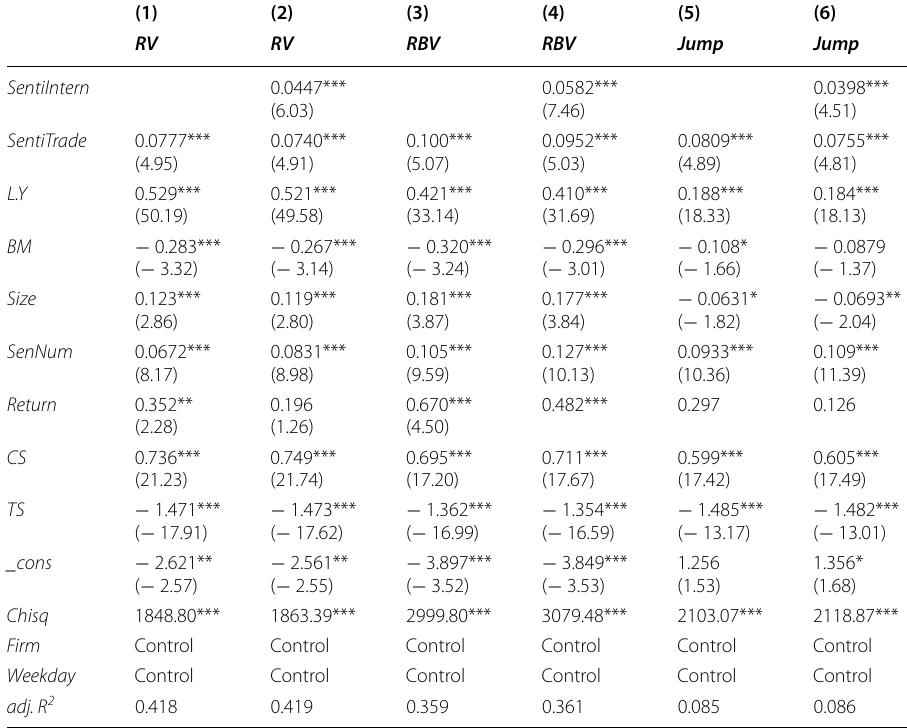
*, **, ***Denote the 10%, 5% and 1% significance level, respectively. Firm and Weekday represent the individual and weekday effects, and Chisq indicates the statistics of the Hausman test. The Hausman test suggests a fixed model at the 1% significance